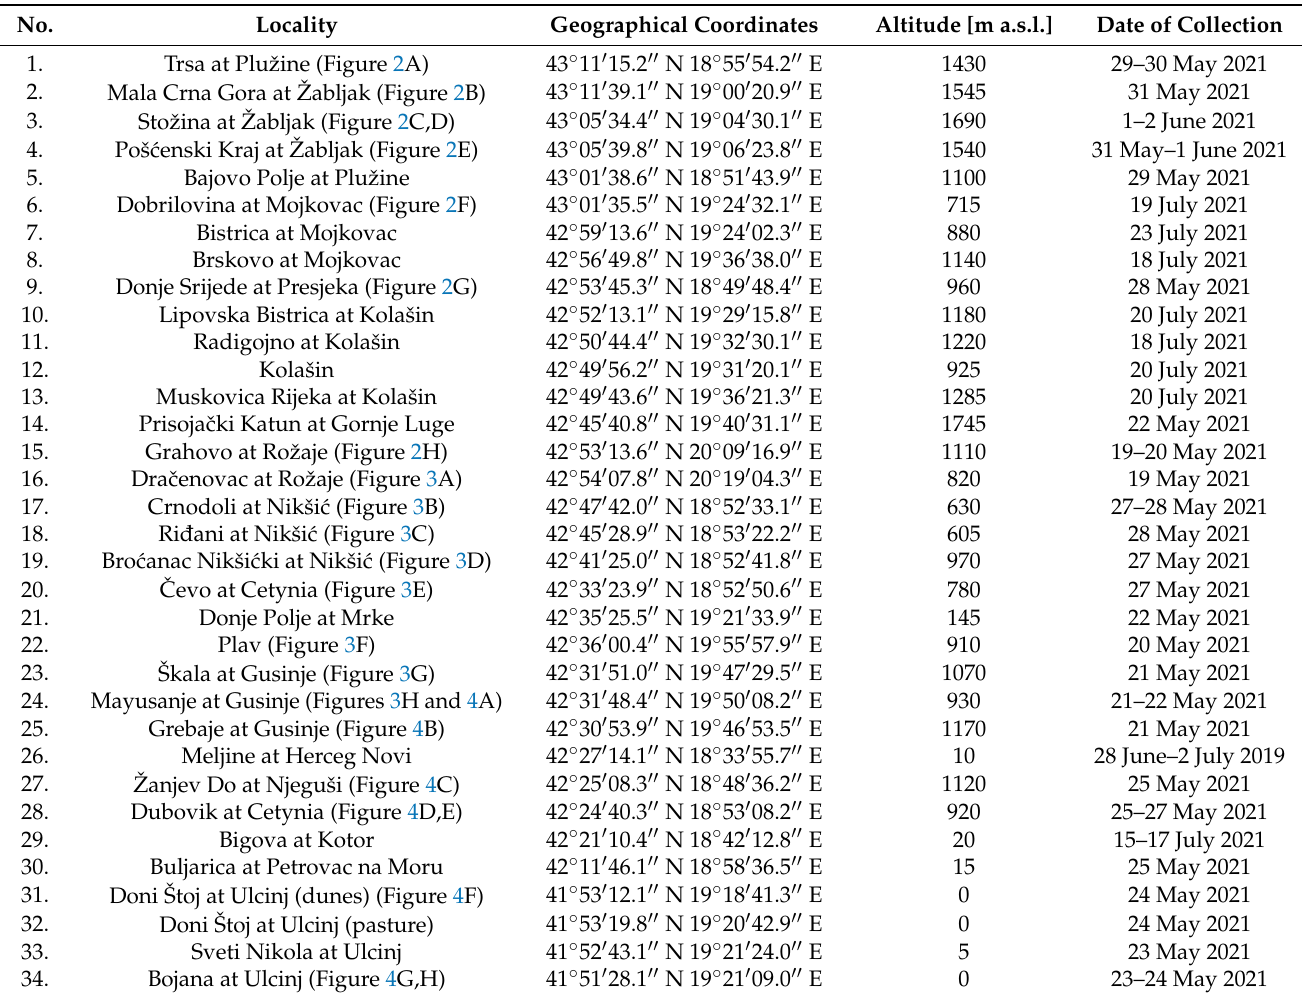
Table 1. Collection localities of the scarabaeoid beetles in Montenegro (2019,